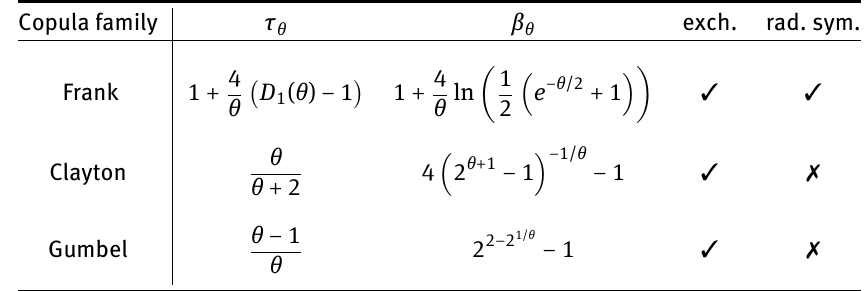
Table 2: Summary of Kendall’s tau, Blomqvist’s beta, and the symmetry properties for the bivariate Frank, Clayton and Gumbel copula. Note: D k ( x ) is the Debye function, which is defined for any k ∈ N by D k ( x ) = k Copula family τ